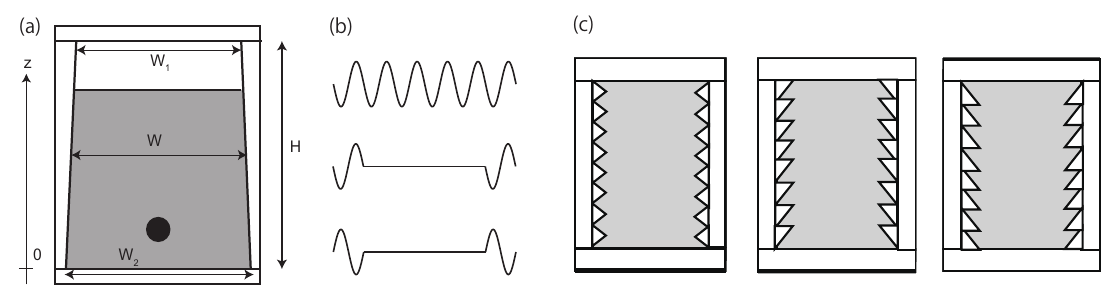
Figure 1. (a) Experimental setup. (b) Continuous vibration vs. two types of discontinuous vibration: down-up and up-down cycles. (c) triangular texture, and upward and downward